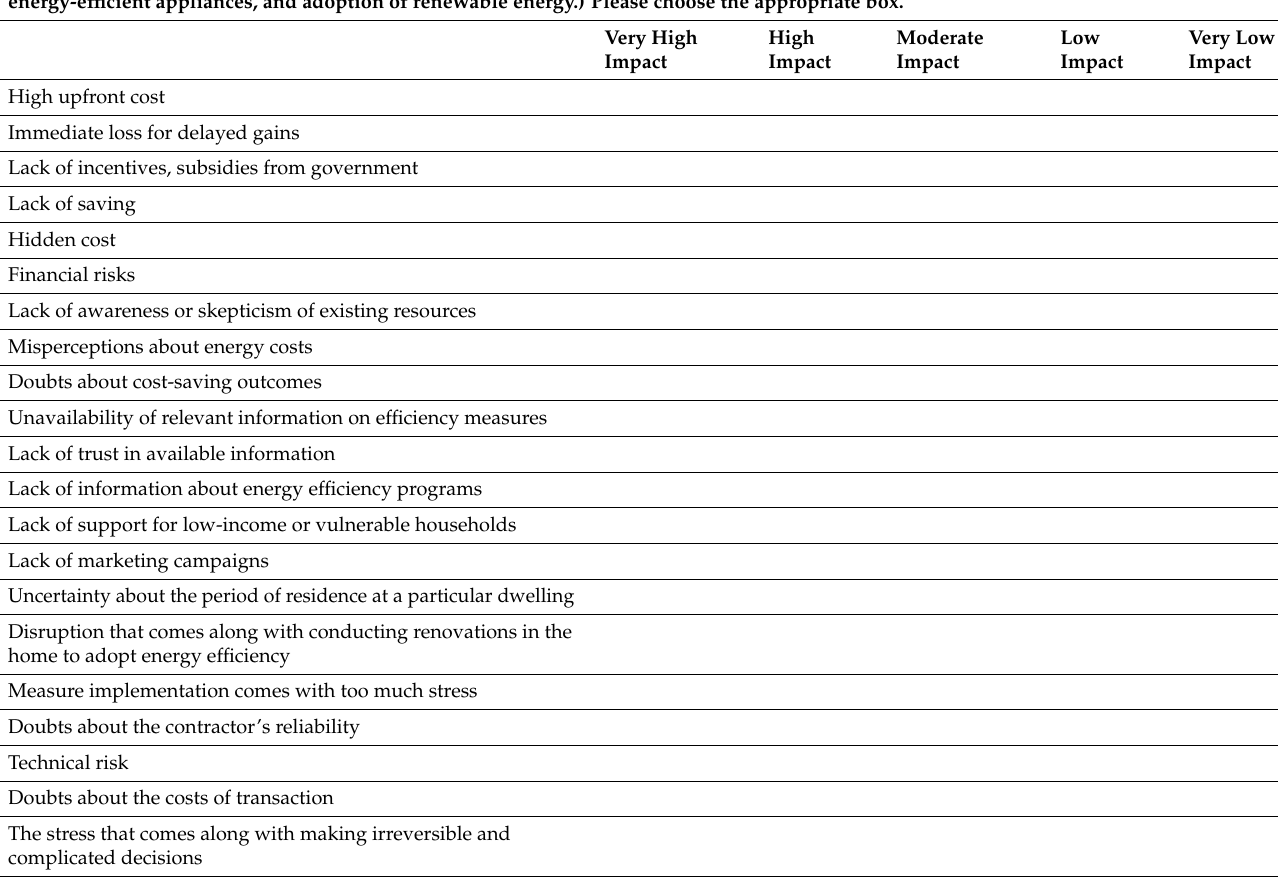
Table A1. An Extract of the Questionnaire